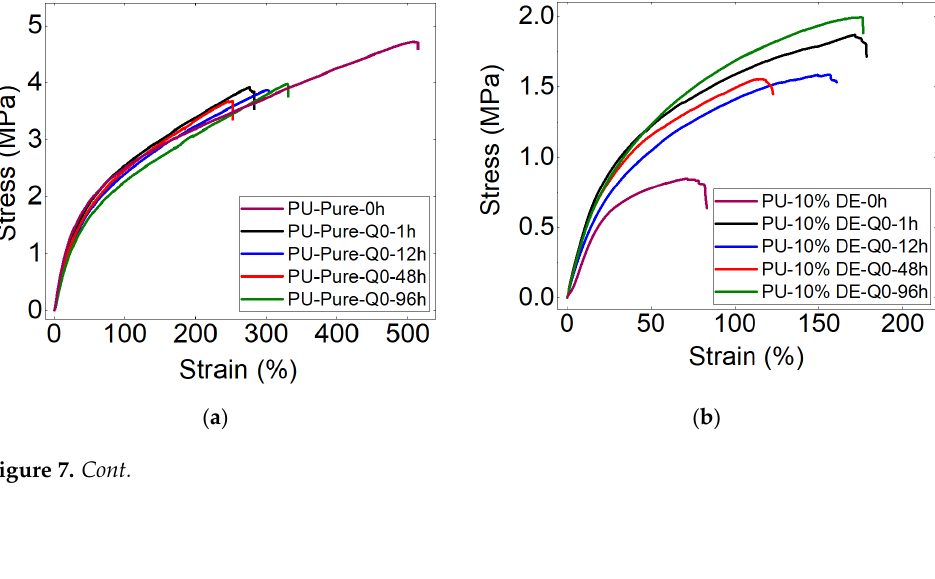
Figure 6. ( a ) Multi-frequency DMTA tests: glass transition temperature evolution (PU-10% DE) and ( b ) linear regression of WLF equation.